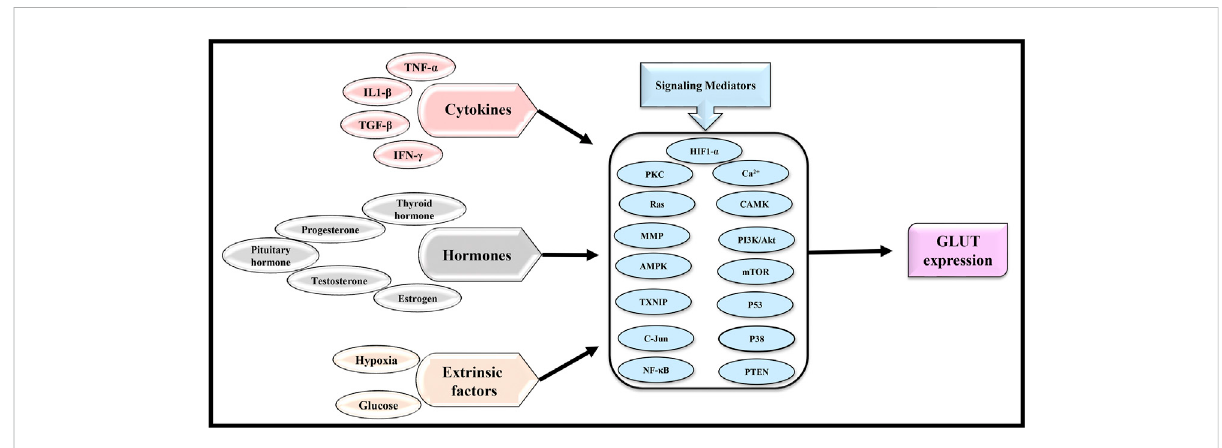
FIGURE 4 RegulationofGLUTexpressionincancercells.IndicatedextrinsicandintrinsicfactorscanregulatetheexpressionofGLUTs via themediatorsof a plethora of signaling messengers, the blend of which could vary in a cancer-speci fi c